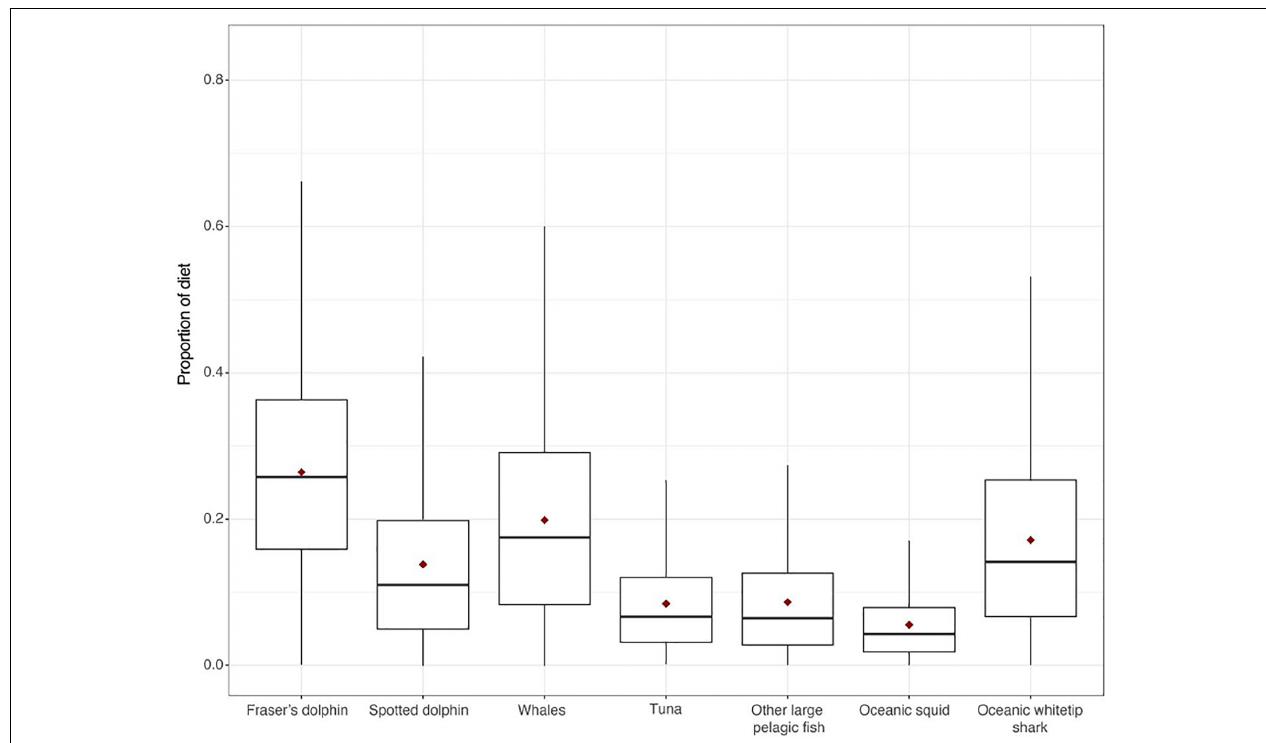
FIGURE 2 | Proportion of dietary contribution of eight different potential prey items to killer whale diets using Bayesian mixing model analysis with trophic enrichment factors (Giménez et al., 2016) of stable isotope samples taken in the Caribbean Sea. Median proportion is indicated as a thick black line, and mean with a red